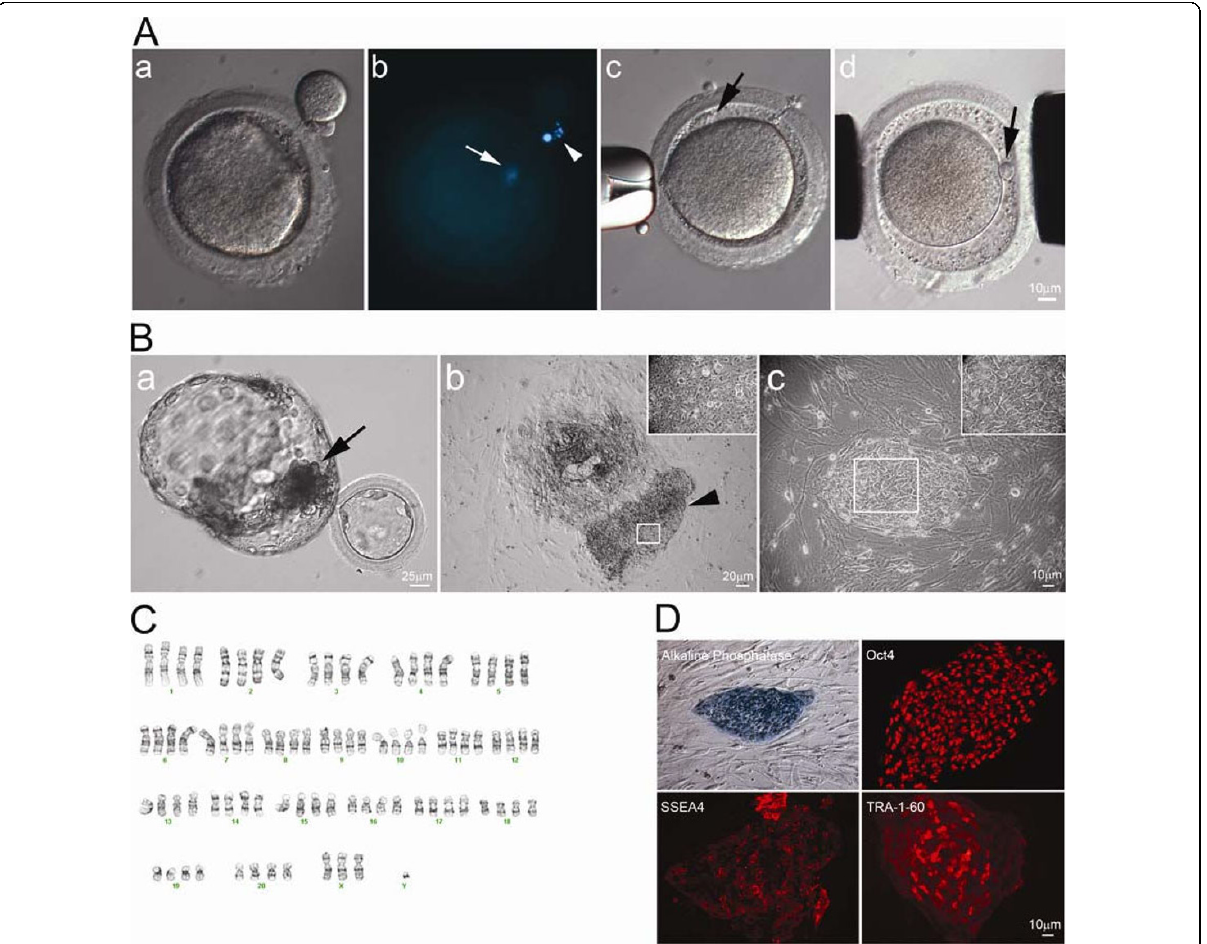
Figure 2 Establishment of HD hybrid cell line . (A) First polar body of mature rhesus macaque oocyte was removed by gentle squeezing through a slit of zona pellucida (A-a). Staining of 1 st polar body DNA (arrowhead) and oocyte DNA (arrow) (A-b). HD monkey skin cell was placed under the zona pellucida (black arrow) (A-c). Reconstructed oocyte with HD monkey skin cell (A-d; yellow arrow) was placed between two electrodes for electrofusion (A-d). (B) Day 12 hatching blastocyst derived from HD monkey hybrid embryo (B-a; arrow indicated ICM). HD monkey hybrid blastocyst outgrowth at six days after attached onto feeder cells (B-b). High magnification of selected region (inset) of the ICM outgrowth (arrowhead). HD monkey hybrid cell line (TrES1) at passage 10 (B-c). (C) G-banding analysis of TrES1. Cytogenetic analysis of TrES1 demonstrated tetraploid chromosome (84; XXXY). (D) Expression of ES-cell specific markers: Alkaline phosphatase, Oct4, SSEA4 and